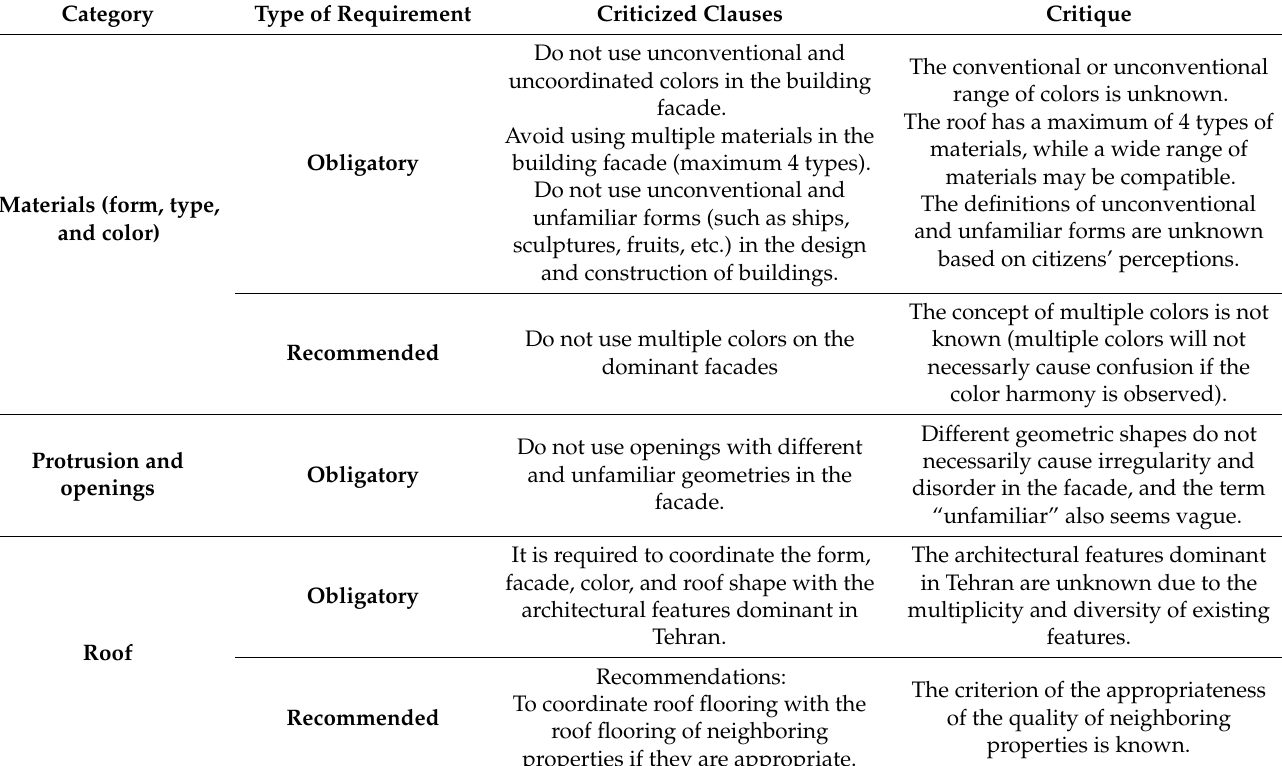
Table 2. Criticized clauses of the 30 general urban facade design codes developed by Tehran Munici- pality (Source: